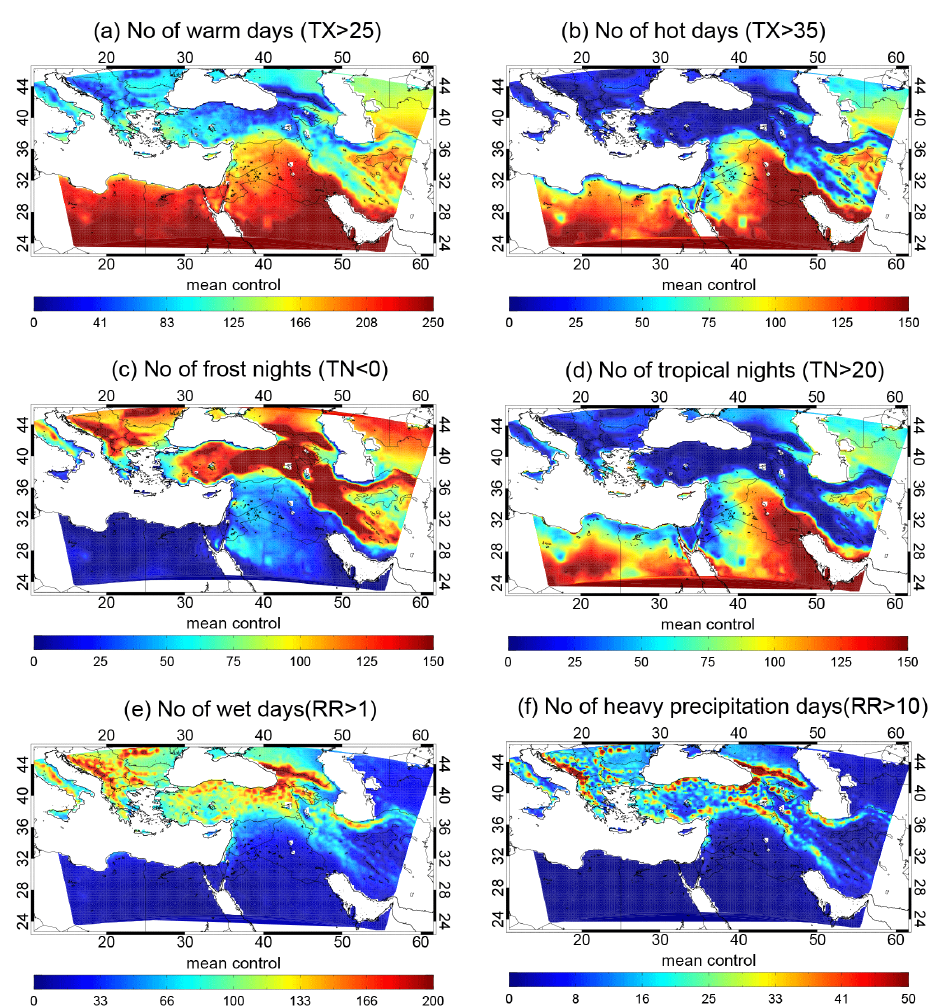
Figure 5. Spatial patterns of the number of warm days (a) , hot days (b) , frost nights (c) , tropical nights (d) , wet days (e) and days with heavy precipitation (f) , per year, during the control period